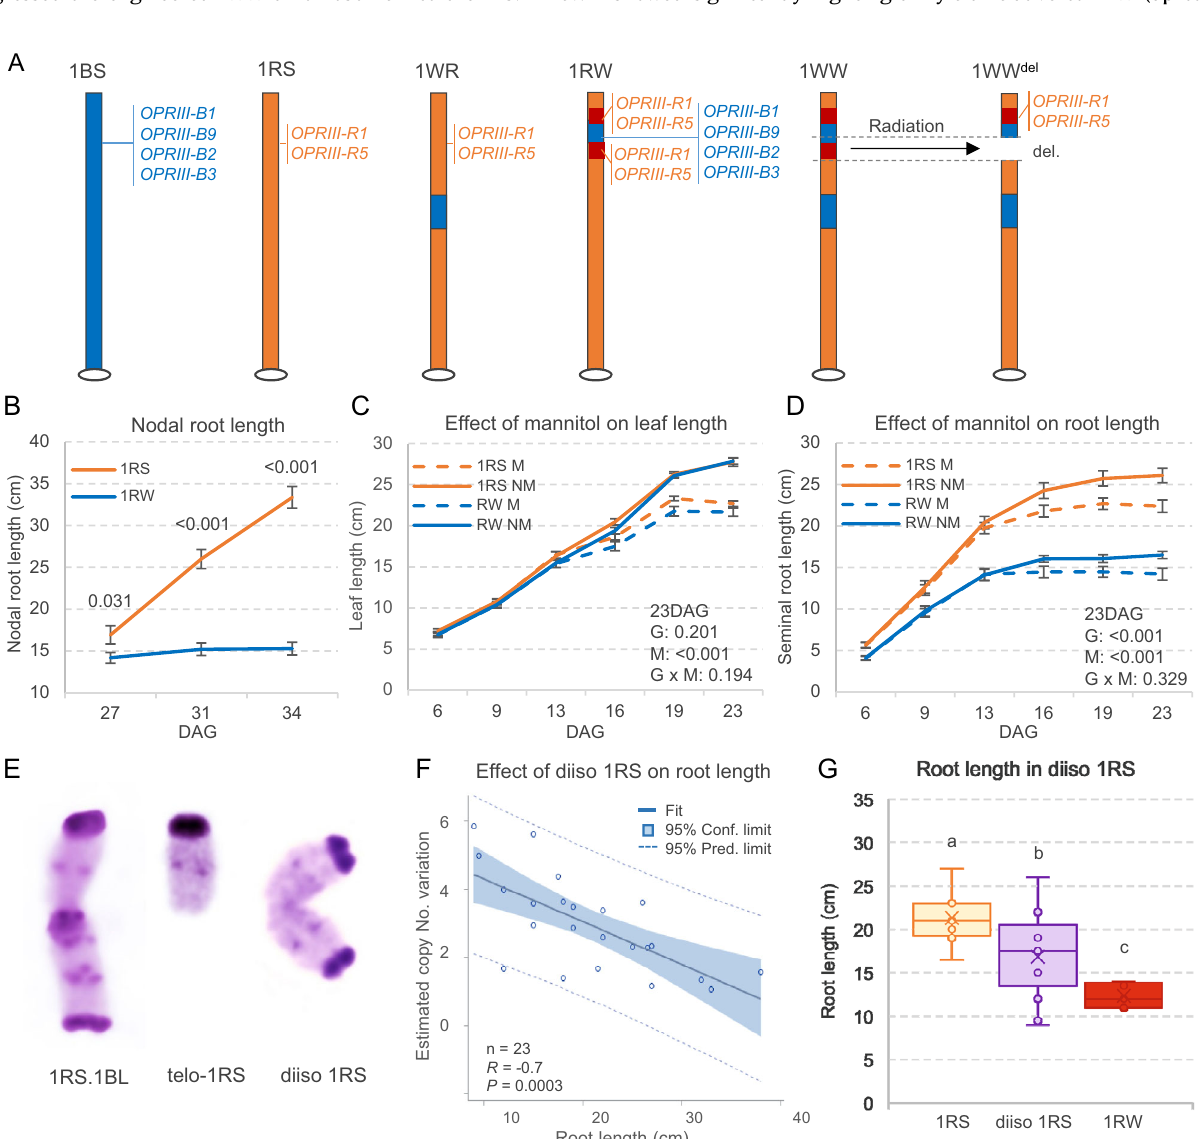
arepresentedasmeansvalues±SEM. E C-bandingofthe1RS.1BLtranslocation,the 1RS telocentric and a diiso 1RS chromosome. Hahn-1RS plants homozygous for diiso 1RS have four extra 1RS arms and, therefore, triple dosage of genes. F Regression between 1RS copy number variation (CNV) and root length in hydroponic tanks 19 DAG ( n =23). The central line indicates the least squares best fi t line. G Seminal root length of 13 diiso 1RS lines with at least one extra 1RS arm (total 3 – 6 1RS arms, average 4.0±0.3) relative to 1RS plants ( n =8, two 1RS arms) and1RWplantswithatriplicated1RS/1BScandidategeneregion( n =8,41RS+21BS copies).Different lettersindicate signi fi cant differencesbasedontwo-tailed Tukey test( P <0.05).Theboxesshowtherangefrom fi rsttothirdquartilesdividedbythe median. The whiskers span from the minimum to the maximum observation and circles indicate individual data. Source data are provided as a Source Data fi